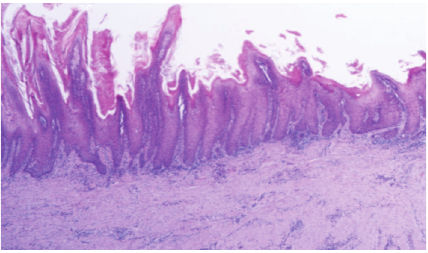
Figure 2: Verrucous carcinoma. Well-differentiated, broad based, papillary neoplasm with acanthosis and hyperkeratosis.